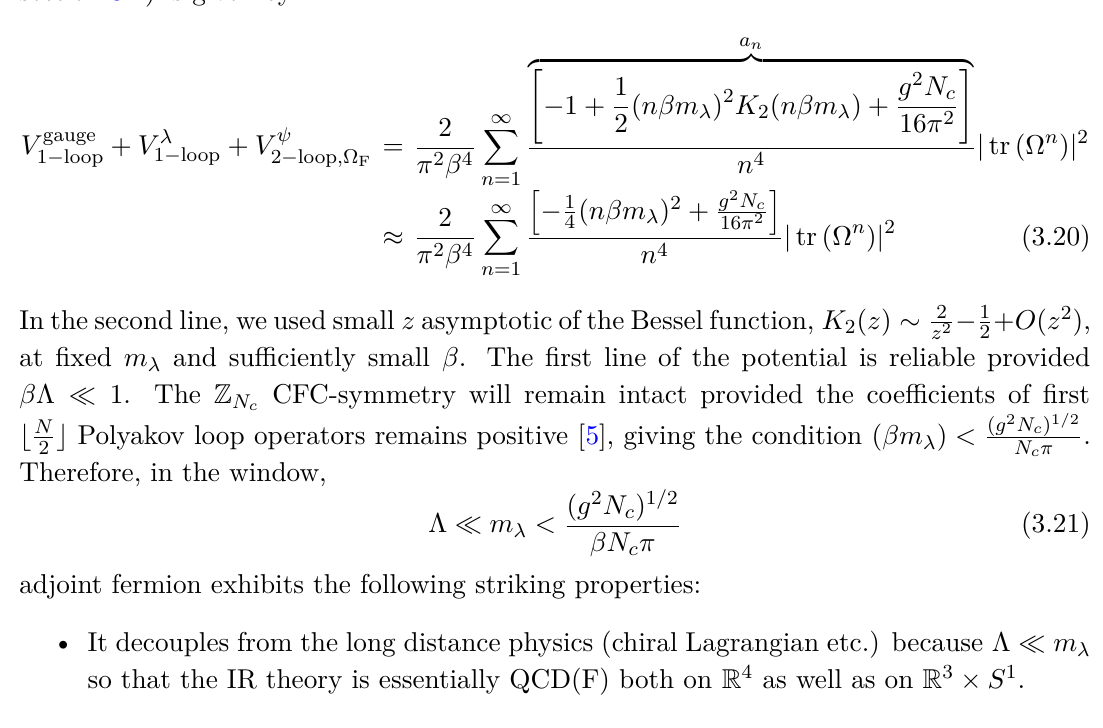
(1.13) as an extremum of the twist-free F being non-dynamical, the extremization of flavor-holonomy F = 1 , the pressure is maximized, for Ω shown F F